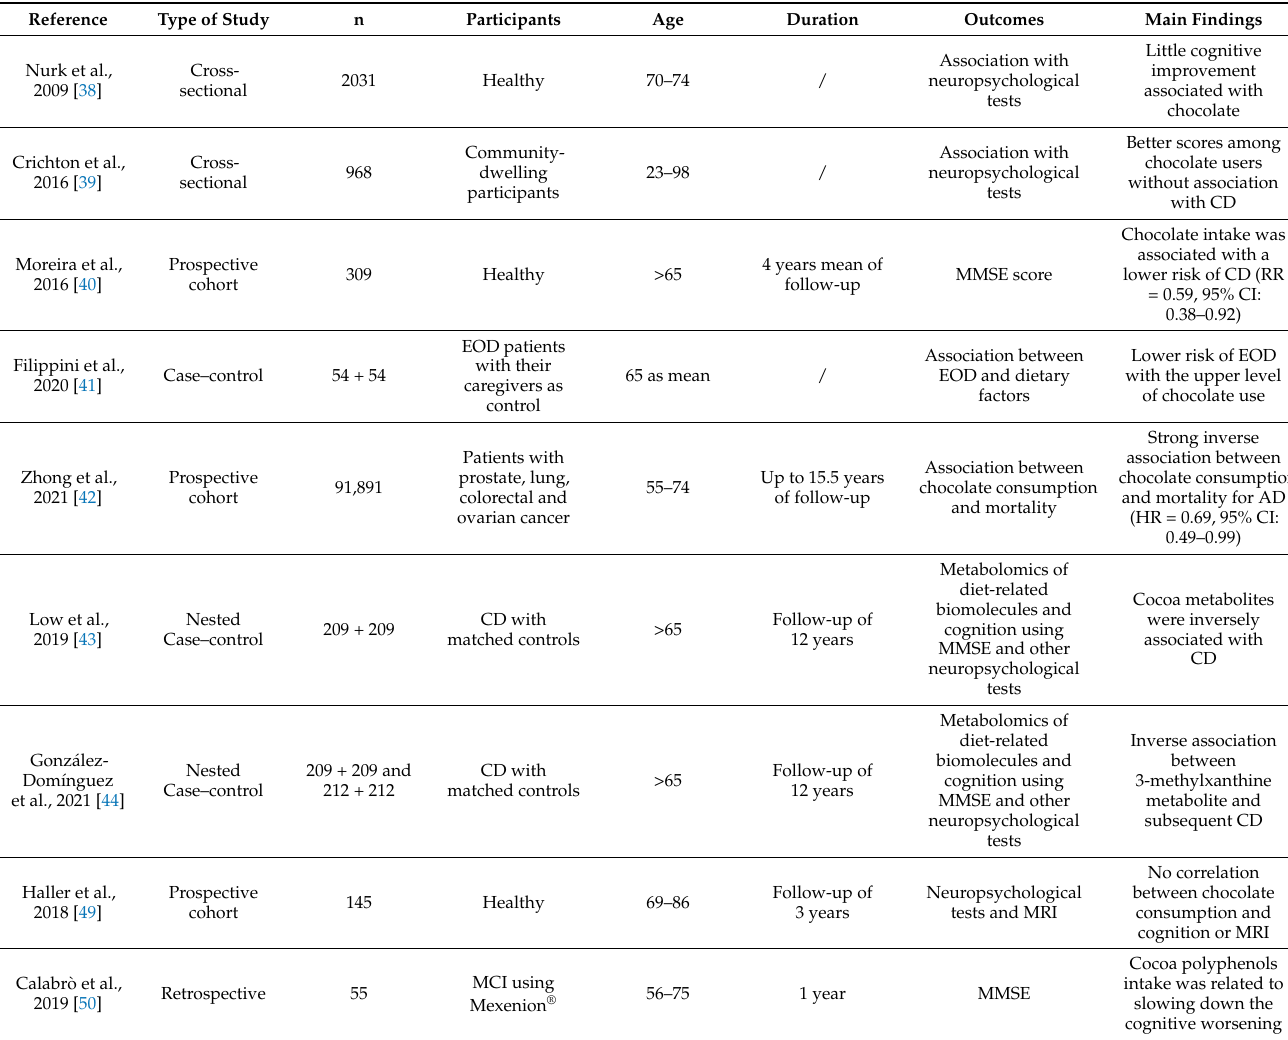
Table 1. Main characteristics of selected observational